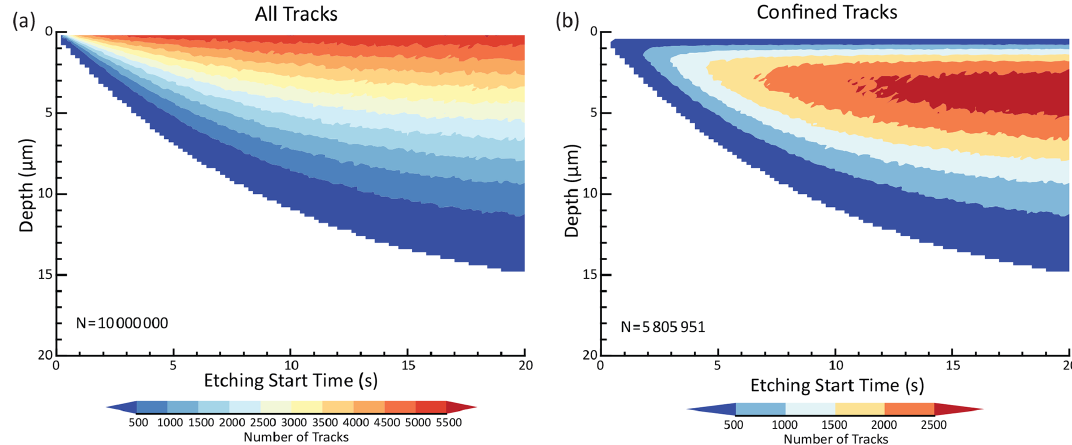
Figure 7. Track intersection results for 10 7 unannealed induced tracks after 20s of etching using the constant-core model for unannealed induced tracks. (a) Contour diagram of all intersections; (b) contour diagram of intersections after excluding tracks that reach the surface